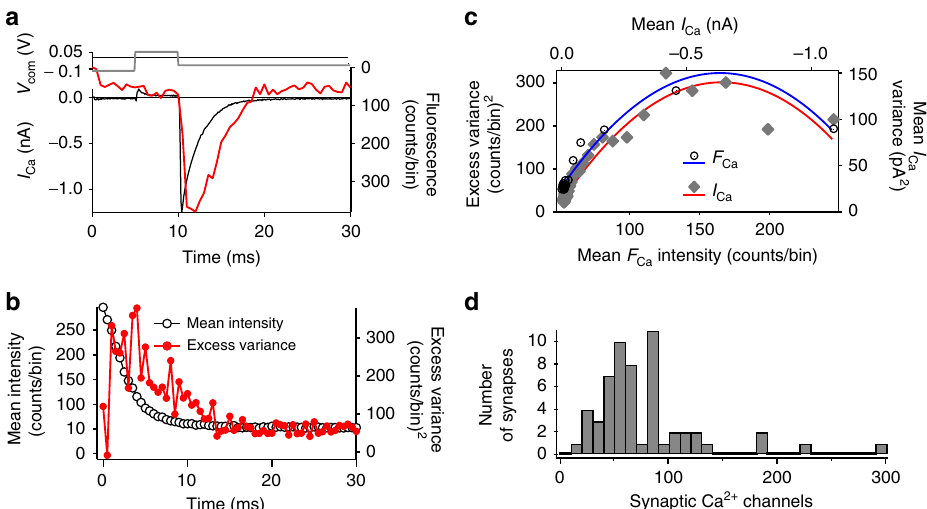
Fig. 4 Estimating the number of Ca 2+ channels per AZ by fl uorescence fl uctuation analysis. a Voltage protocol (upper panel) used to evoke Ca 2+ in fl ux, visualized by the fl uorescence signal ( F Ca , red trace, lower panel, note that increase points down for comparison with current) of local Ca 2+ in fl ux at a single synapse and simultaneously by recordings of whole-cell Ca 2+ current ( I Ca , black trace, lower panel). b Trial-to-trial variance (red trace) and mean (black circles) of fl uorescence. c Plot of baseline-subtracted variance of synaptic fl uorescence (open circles) or of whole-cell Ca 2+ current ( fi lled diamonds) against mean fl uorescence or current, respectively, from the exemplary cell shown in b . Lines indicate the fi ts of quadratic functions to the fl uorescence data (blue) or the Ca 2+ -current data (red). Extrapolation of these fi ts back to baseline allows calculation of the total number of channels in the cell (from the Ca 2+ -current data) or at one AZ (from the fl uorescence data). d Histogram of the number of Ca 2+ channels, obtained from quadratic fi tting of variance against mean as shown in d , to data from n = 57 AZs from N = 16